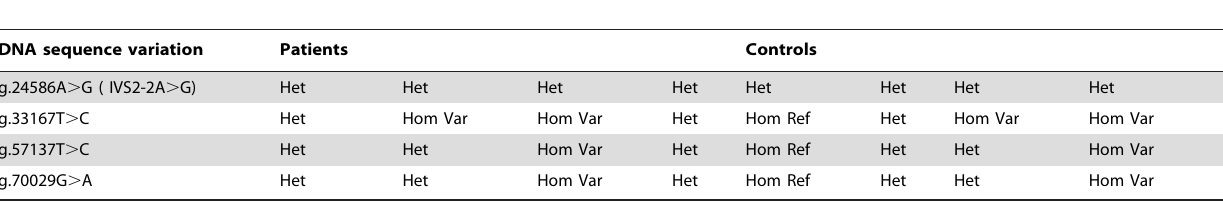
Table 4. Other DNA sequence variations observed in SLC26A5 IVS2-2A . G